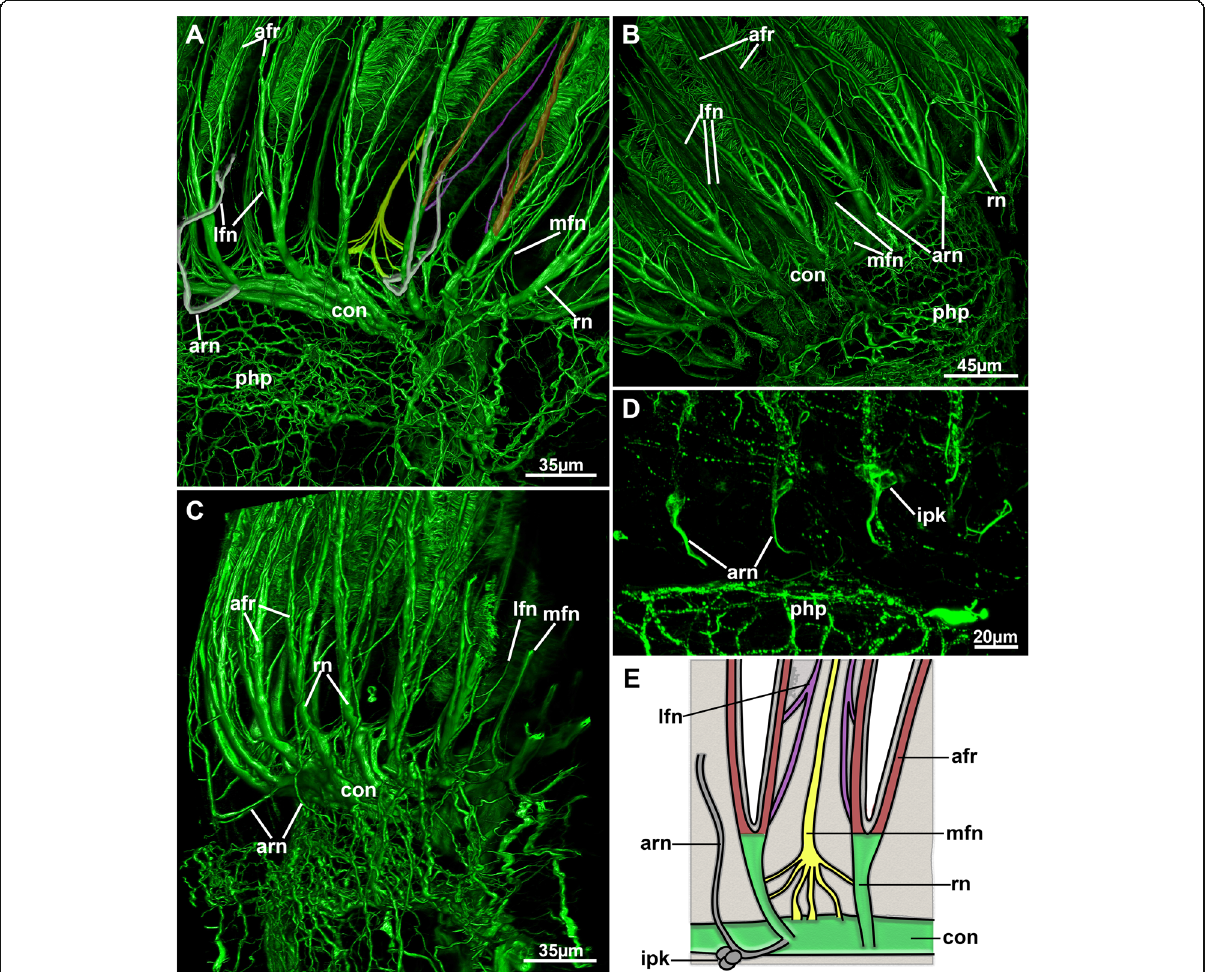
Fig. 19 Detail of the tentacle innervation of Stephanella hina . a Lateral view of the lophophoral base showing the main tentacle neurite branches. One medio-frontal neurite bundle has been marked in yellow, one latero-frontal pair in purple, one pair of abfrontal neurite bundle roots in red and two additional radial neurite bundles in grey. b Similar view as in A showing major neurite bundle origins from the circum-oral nerve ring. c Lateral view of the lophophoral base showing the traversal of the additional radial nerve/neurite bundle supplying the outer lophophoral base. d & e Intertentacular perikarya at the additional radial neurite bundle. d Optical section. e Schematic drawing of the main tentacle neurite bundles. Abbreviations: afr – abfrontal neurite bundle roots, arn – additional radial nerve/neurite bundle, con – circum-oral nerve ring, ipk – intertentacular perikarya, ph – pharynx, lfn – latero-frontal neurite bundles, mfn – medio-frontal neurite bundle, php –